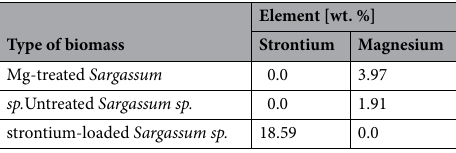
Table 4. The amount of magnesium and strontium in the biomass.